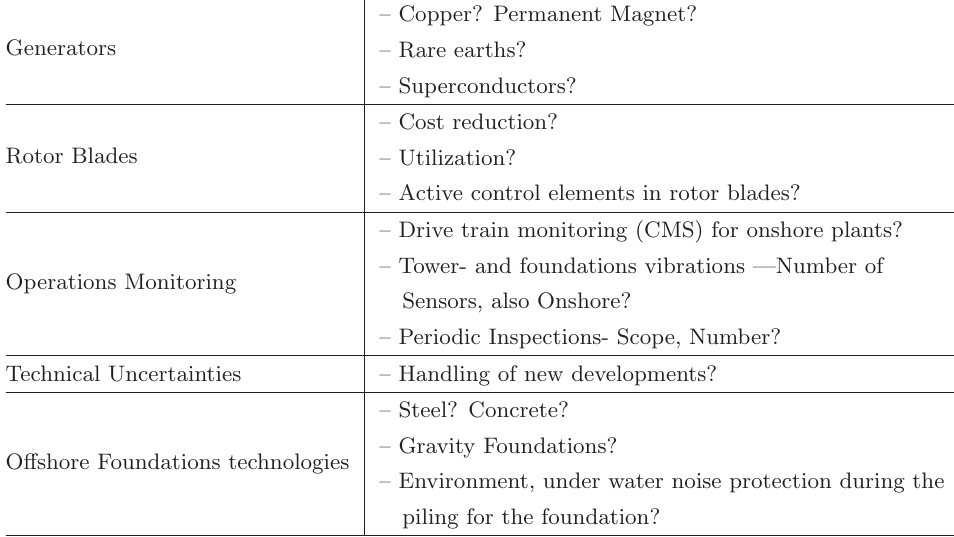
Table V. – Technical developments in wind turbines [6]